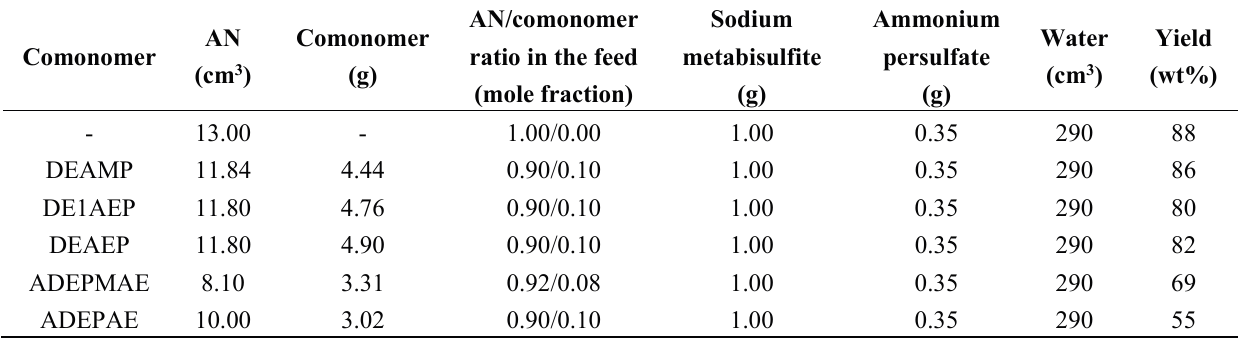
Table 1. Preparative data for acrylonitrile (AN)-based